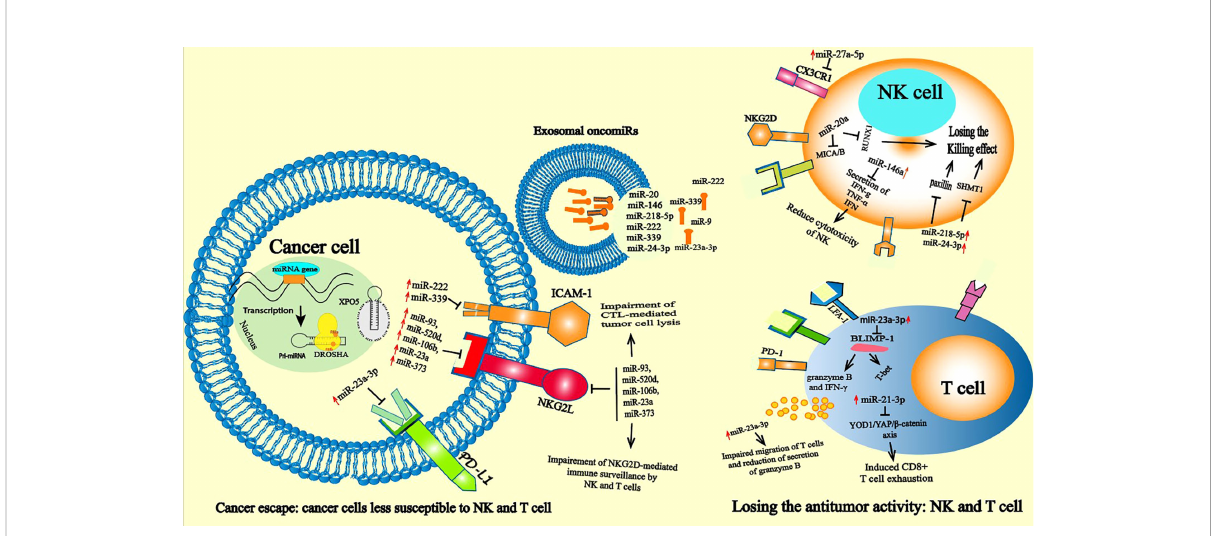
FIGURE 2 oncomiRs induced immune suppression: Leukocyte in fi ltration into tumor tissue and recognition of malignant cells are necessary for successful immune elimination. Impaired antitumor activities of T cells and NKs are a major goal of cancer cells. The growth and development of tumors is associated with high alterations in antigenic patterns that lead to attenuated recognition of cancer cells by NK and T cells. At the cancer level, oncomiRs such as miR-22 miR-23a miR-339 tumor cells can affect the activation of immune cells and then control tumor behavior by targeting the expression of the protein like PD-1, NKG2L and ICAM-1, thus preventing the recognition of cancer cells by NK and T cells. In the immune cells oncomiR drive immunosuppressive state by directly or indirectly controlling killing effect of NK cells and affecting the cytotoxicity effect of T cells. The overexpression of oncomiRs in T cells such as miR-23a-3p induces T cell apoptosis through the PD-L1/PD-1 pathway by inhibiting the tumor suppressor PTEN expression and subsequently activates protein kinase B (AKT)